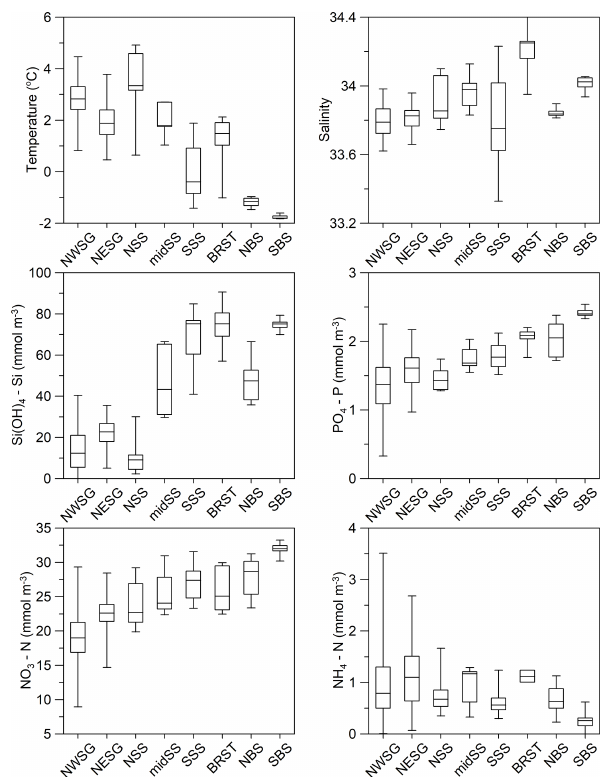
Figure 8. Regional variability in physical and chemical near- surface (0–50m) ocean properties for austral summer profile data. The box and whisker plots comprise a box that is defined by the re- gion’s lower and upper quartiles, the line in the centre of the box is the median, and the whiskers indicate the extreme values (minimum and maximum). Refer to Fig. 7 for sample locations and to Table 4 for temporal coverage and numbers of data